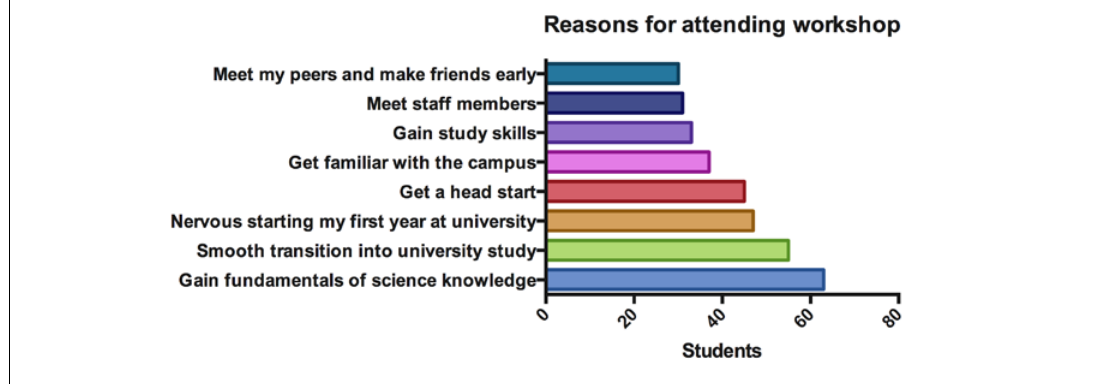
Figure 1: Number of students selecting each reason for